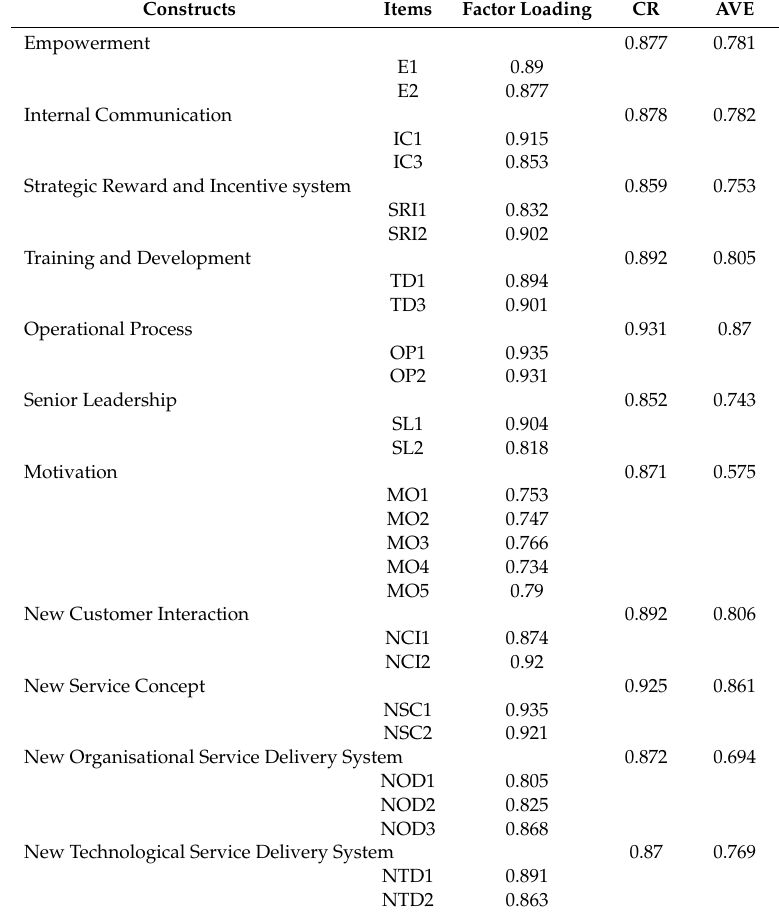
Table 3. Assessment of the first-order reflective measurement